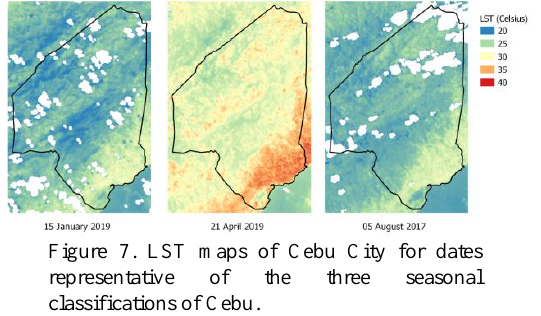
Figure 7. LST maps of Cebu City for dates representative of the three seasonal classifications of Cebu.